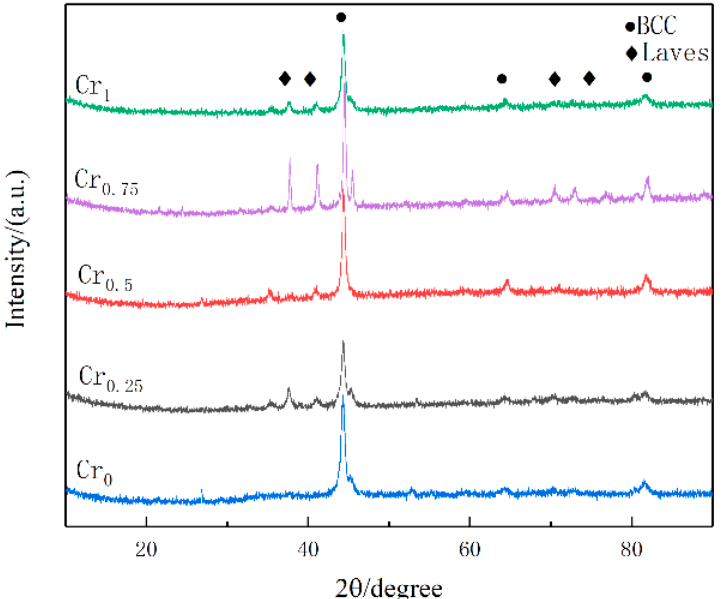
Figure 4. XRD of WVTaTiCr x high entropy alloy coating.